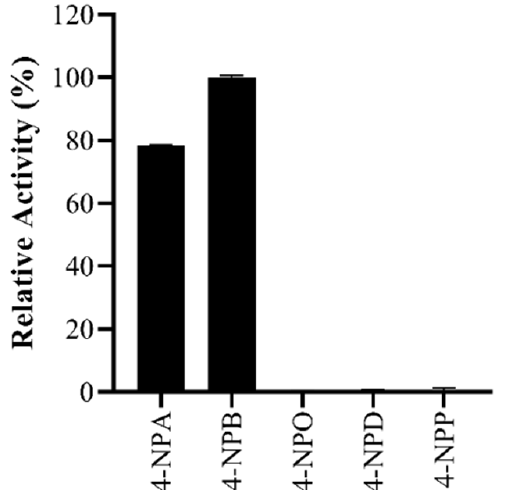
Figure 4. Activity assay. BaAXE was assayed using various acyl chain esters (C2–C16). 4-NPA— 4-nitrophenyl acetate; 4-NPB—4-nitrophenyl butyrate; 4-NPO—4-nitrophenyl octanoate; 4-NPD— 4-nitrophenyl decanoate; 4-NPP—4-nitrophenyl palmitate. The assay reaction was carried out with a 1 mM concentration of each substrate, and the reaction proceeded for 20 min at 40 ◦ C. Absorbance readings were taken at 410 nm at 1 min intervals. Each bar represents activity on each substrate, n = 3 and the error bar corresponds to the standard error of the mean